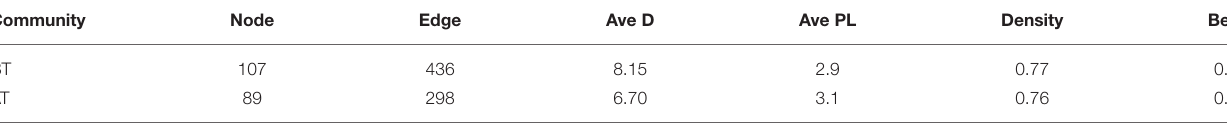
TABLE 1 | Properties of before treatment and after treatment co-occurrence sub-networks. Community Node Edge Ave D Ave PL Density Bet C